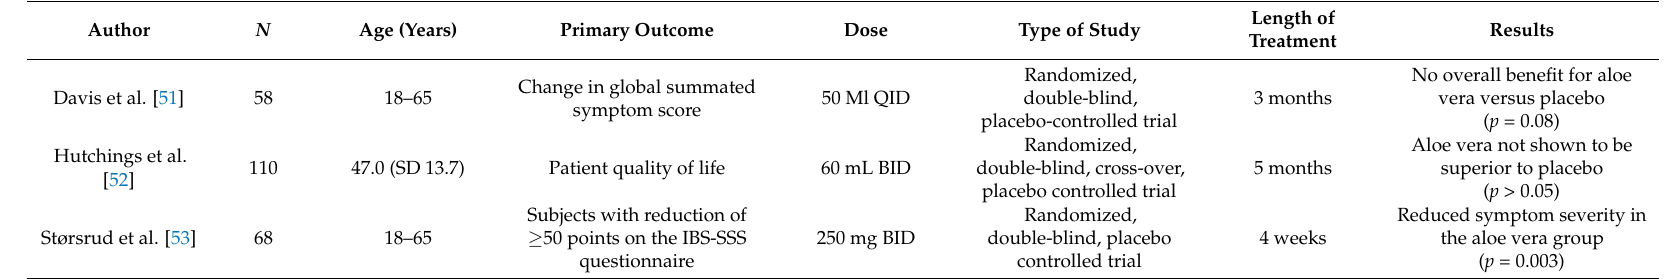
Table 5. Clinical Trials on Aloe Vera in the treatment of functional gastrointestinal